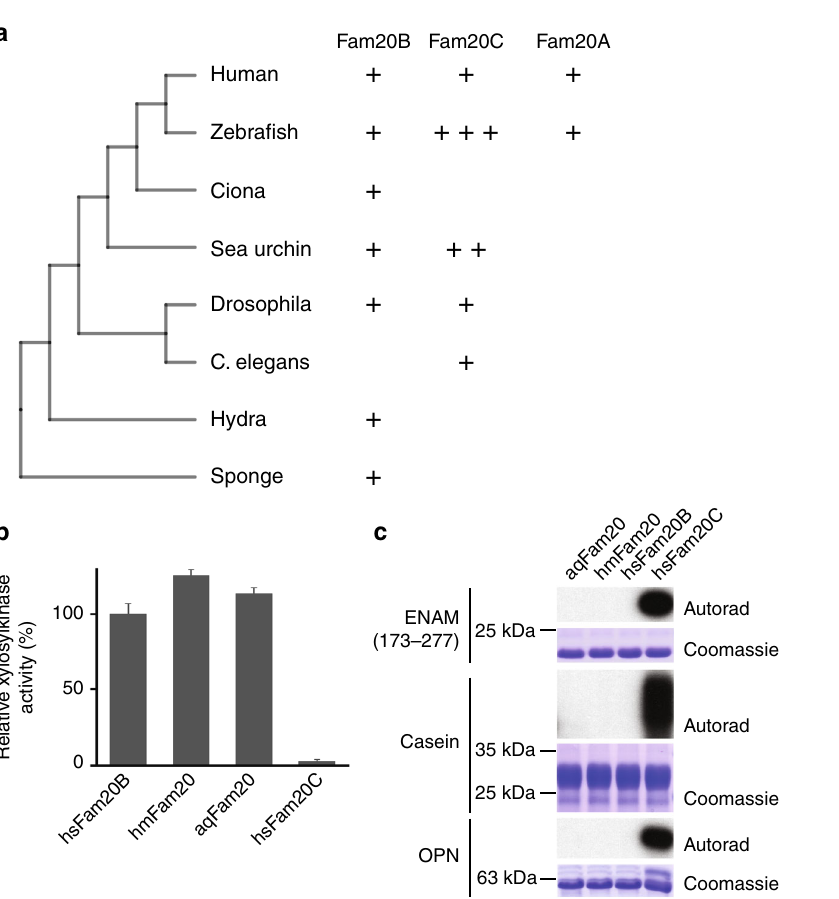
Fig. 4 The Fam20A − Fam20C tetramer. a The crystal structure of Fam20A − drFam20C reveals a four-leaf clover-shaped tetramer formed by two Fam20A − drFam20C heterodimers. The side chain of Asn298 A is shown. The positions of Lys129 A , Arg132 A , and Arg136 A in the N α 2 A helix are highlighted in red. The side chains of these three residues are not clearly visualized in the structure. b The E299G/I300S and K129A/R132A/R136A mutants of Fam20A activate Fam20C at levels comparable to WT Fam20A in vitro